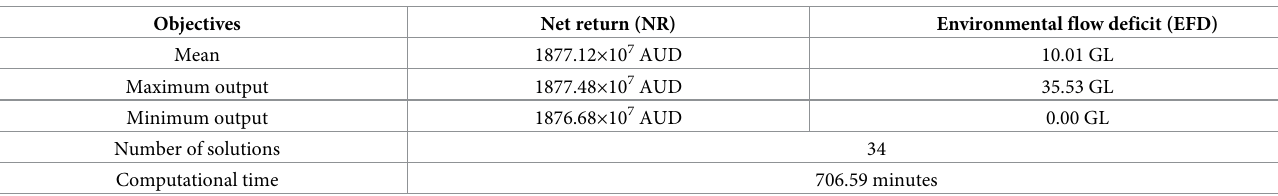
Table 6. Summary for 300